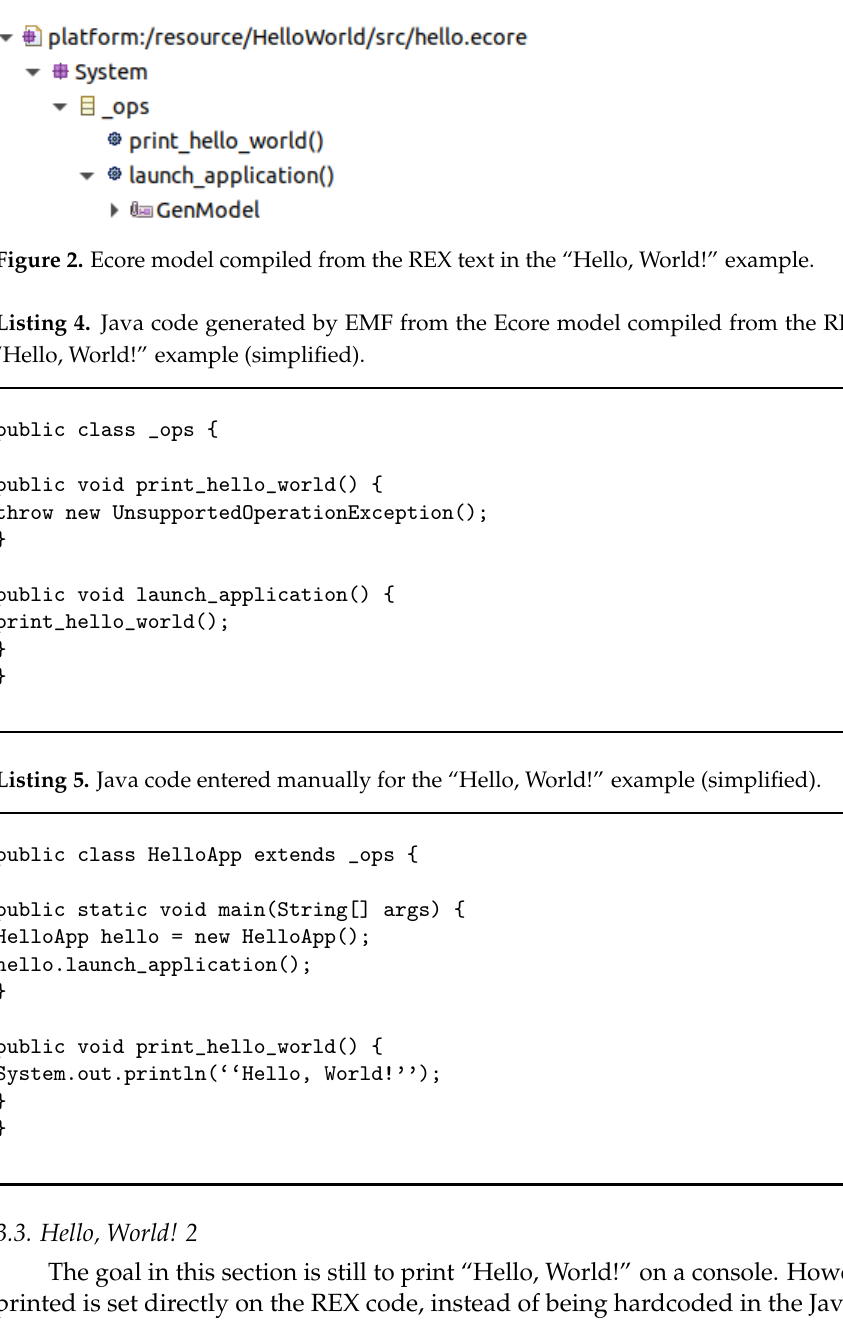
Figure 1. AST of the REX text in the “Hello, World!” example.